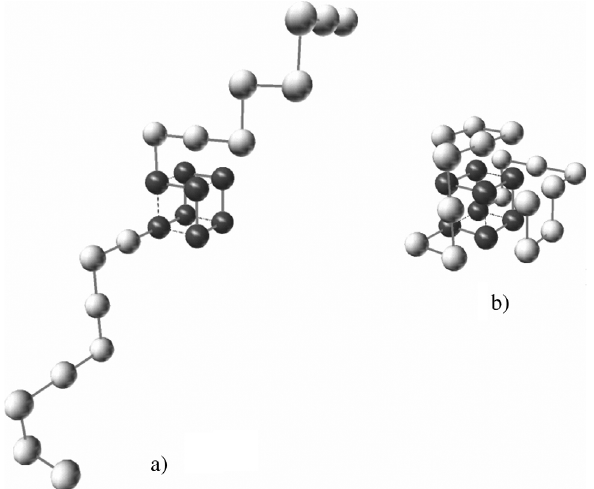
Figure 2 - Structures from sequence [PPPPPPPPHHHHHHHHPPPPP PPP]underthedifferentmodels.Darkspheresarehydrophobicmonomers and white spheres polar. The dotted line indicates a hydrophobic contact and the continuous line is the backbone. A: original model, 5 hydropho- bic-hydrophobic (H-H) contacts, compactness 0.5 and segregation 0.72. B: modified model, 5 H-H contacts, compactness 1.58, segregation 1.14.